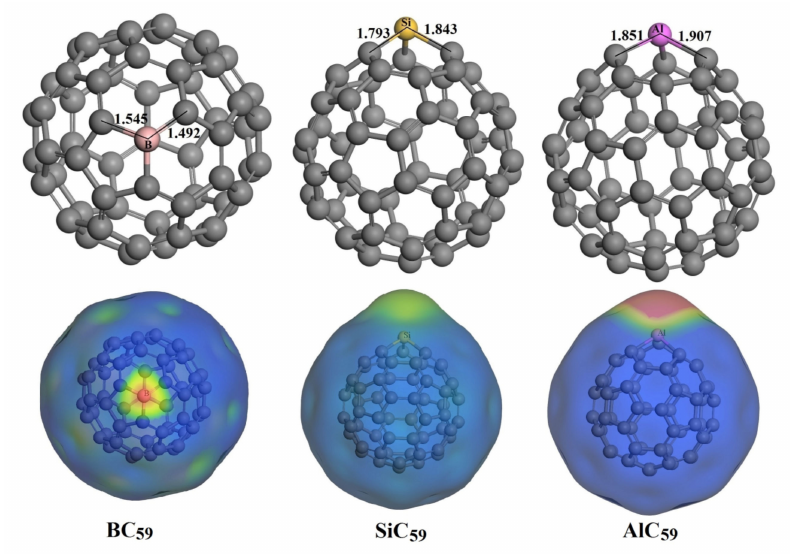
Figure 3. Optimized structures and the corresponding molecular electrostatic potential (MEP) plots of BC 59 , SiC 59 , and AlC 59 . Here, in the MEP plot the blue and red colors correspond to more negative and positive electrostatic potentials regions, respectively. All bond distances are in